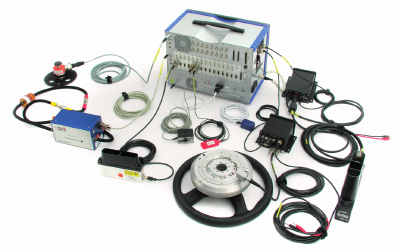
Figure 5. Connections for the Dewetron testing